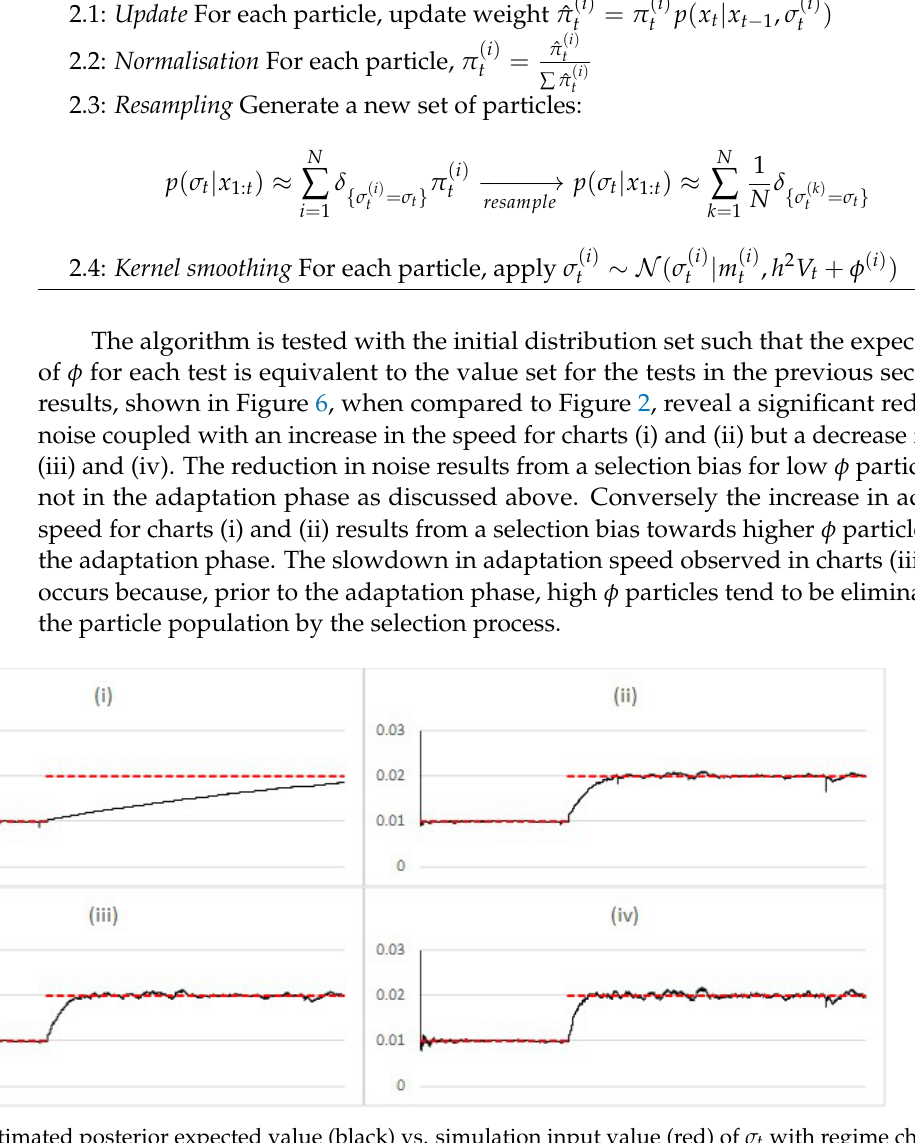
Figure 6. Comparing estimated posterior expected value (black) vs. simulation input value (red) of σ t with regime change after 10,000 steps, using the Liu and West filter with additional noise parameter φ ( i ) ∼ U ( 0, c ) with c set to ( i ) 0.2 ( iii ) 20.0 ; ( iv ) 200.0 N N